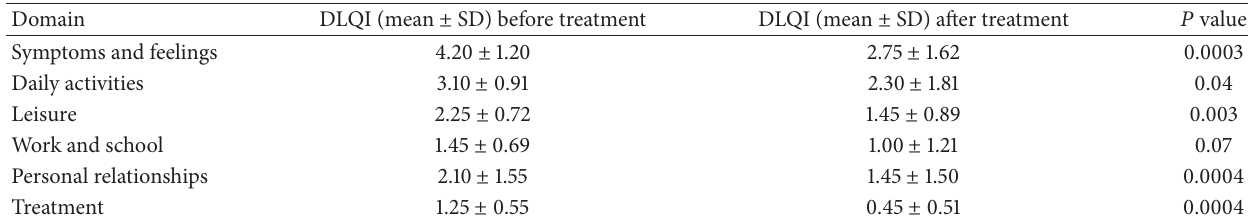
Table 4: Comparison of different domains of DLQI at baseline and after 12 weeks of